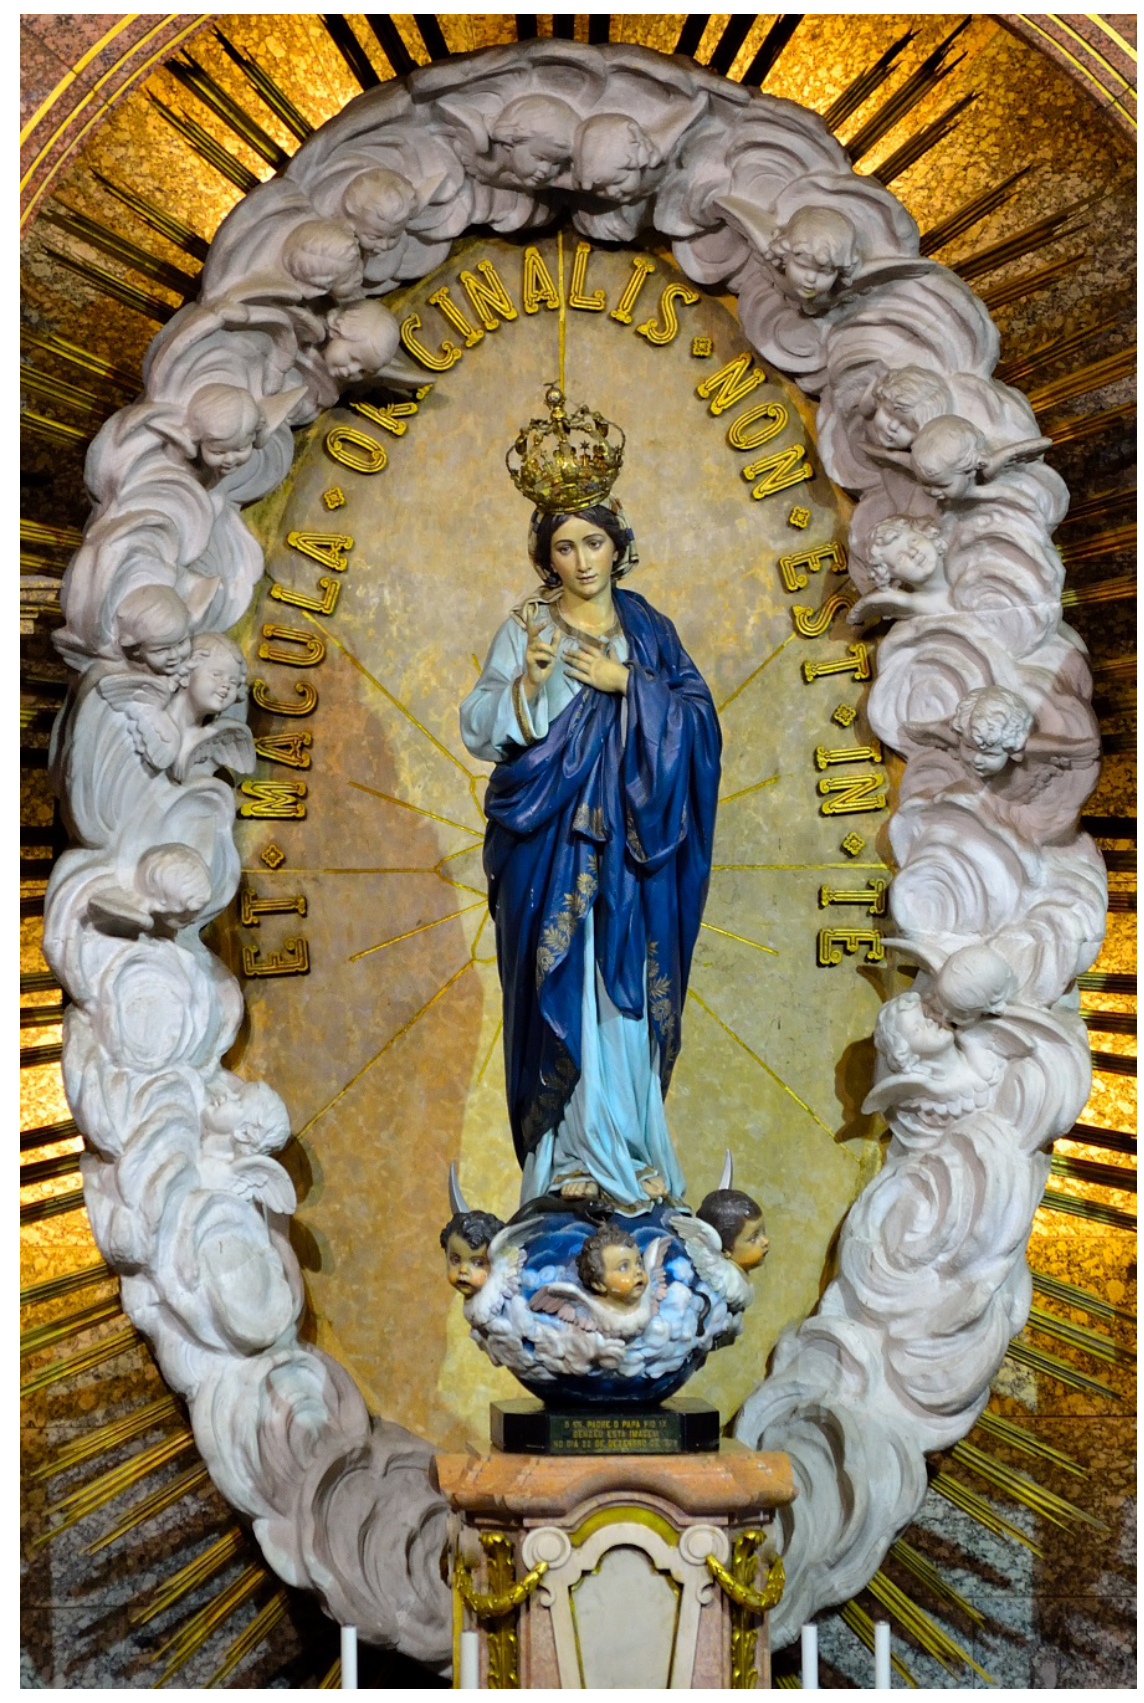
Figure 4 Our Lady of Sameiro , Sanctuary of Our Lady of Sameiro, Braga, Portugal. Permission of Santuário do